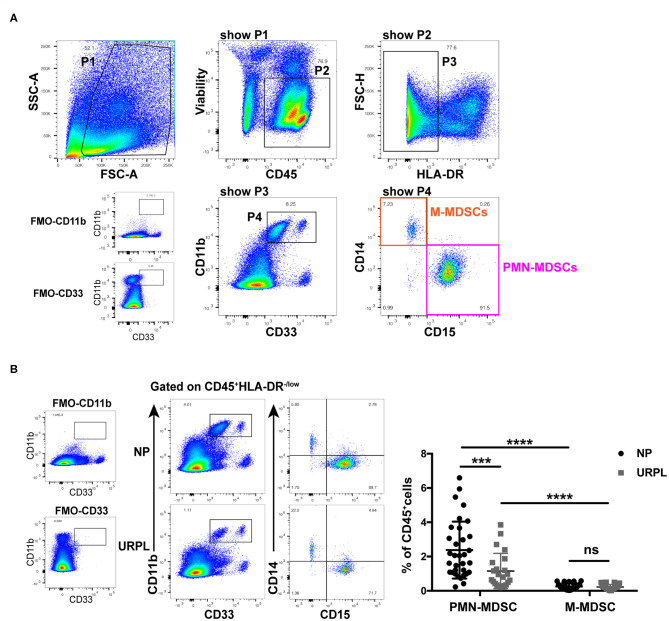
Phenotypic characteristics and frequency of MDSC subsets of human decidual tissue in the normal pregnancy (NP) group and the unexplained recurrent spontaneous abortion (URPL) group. (A) Representative flow cytometry showing gating strategy of PMN-MDSC (gated on HLA-DR−/lowCD11b+CD33+CD15+CD14−) and M-MDSC (gated on HLA-DR−/lowCD11b+CD33+CD15−CD14+) in decidua. (B) Representative flow cytometry of decidual PMN-MDSC and M-MDSC of the NP and the URPL group (left). Percentage of decidual PMN-MDSC and M-MDSC of NP (n = 33) and URPL (n = 23) (right) were analyzed (mean ± SD, Mann-Whitney U-test). ***P < 0.001; ****P < 0.0001; ns, not significant. FMO, Fluorescent minus one.